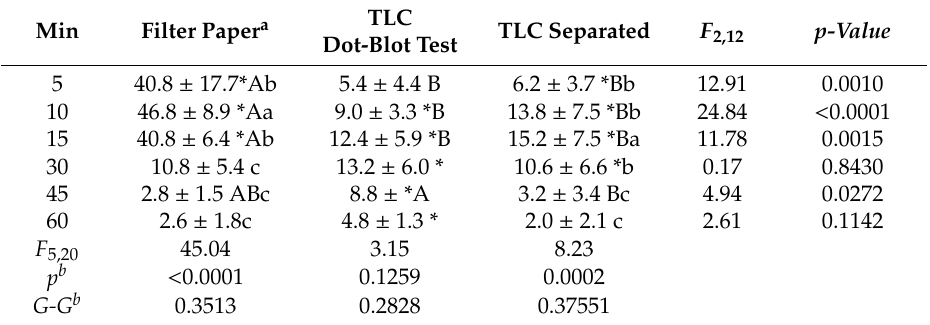
Table 1. The number of sterile male C. capitata attracted in small cage bioassays (100 flies per cage). Flies were given the choice of a solvent control and either 10 µ L of 10% TTO applied to filter paper, applied to a TLC plate (TLC dot-blot test without the migration of TTO) and applied to a TLC plate and separated in n -hexane:acetone (90:10, v / v ) (Experiment 1, n =